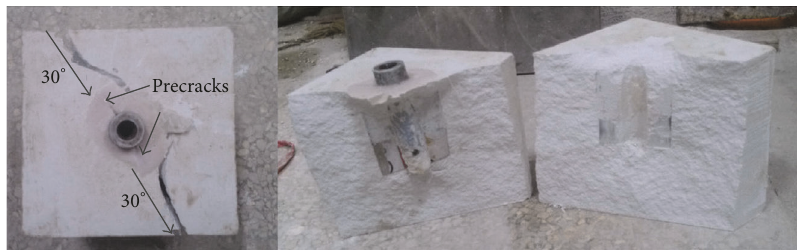
Figure 18: Experimental result of model I test [37].